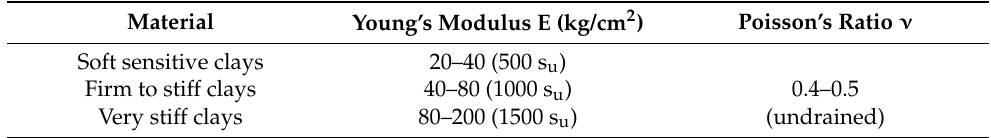
Table 3. Modulus of elasticity of soils/clays (data from Ref.